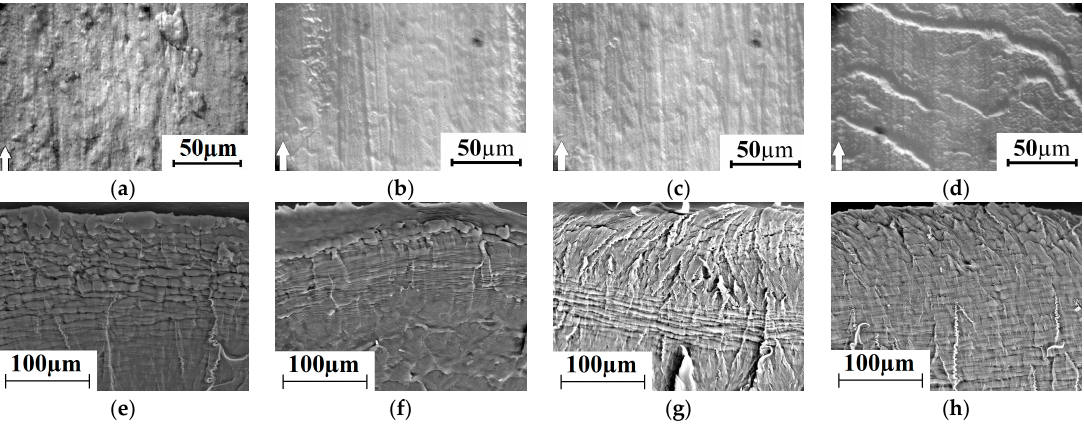
Figure 11. SEM-micrographs of the UHMWPE wear surfaces and subsurface layers: ( a , e )—P = 60 N, V = 0.3 m / s; ( b , f )—P = 60 N, V = 0.5 m / s; ( c , g )—P = 140 N, V = 0.3 m / s; ( d , h )—P = 140 N, V = 0.5 m / s.